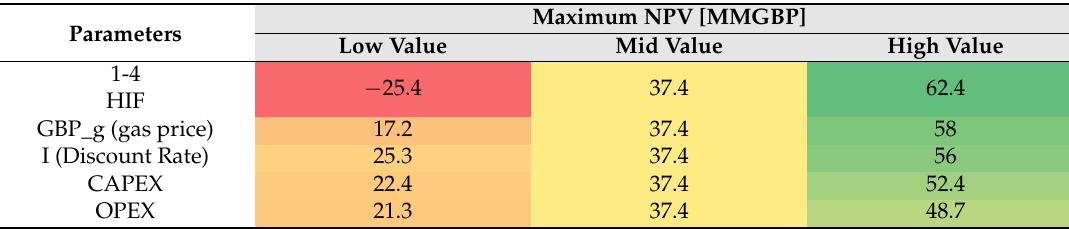
Figure 3. NPV sensitivity analysis showing the significant role of HIF parameter. Table 2. Sensitivity analysis results. Different values are color coded with colors ranging from red (representing the lowest NPV value) to dark green (representing the highest NPV value).